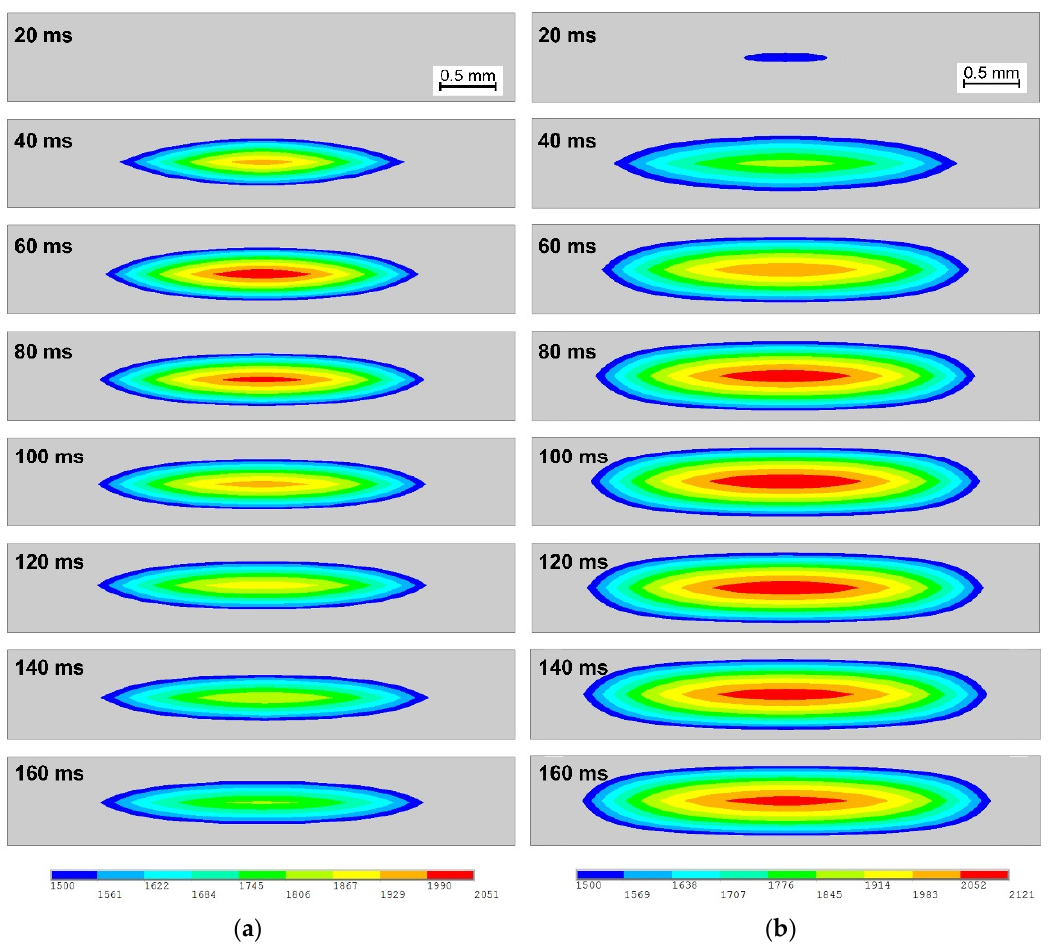
Figure 4. Comparison of weld formation process of ( a ) without strip and ( b ) with a 0.10 mm AISI304 strip.